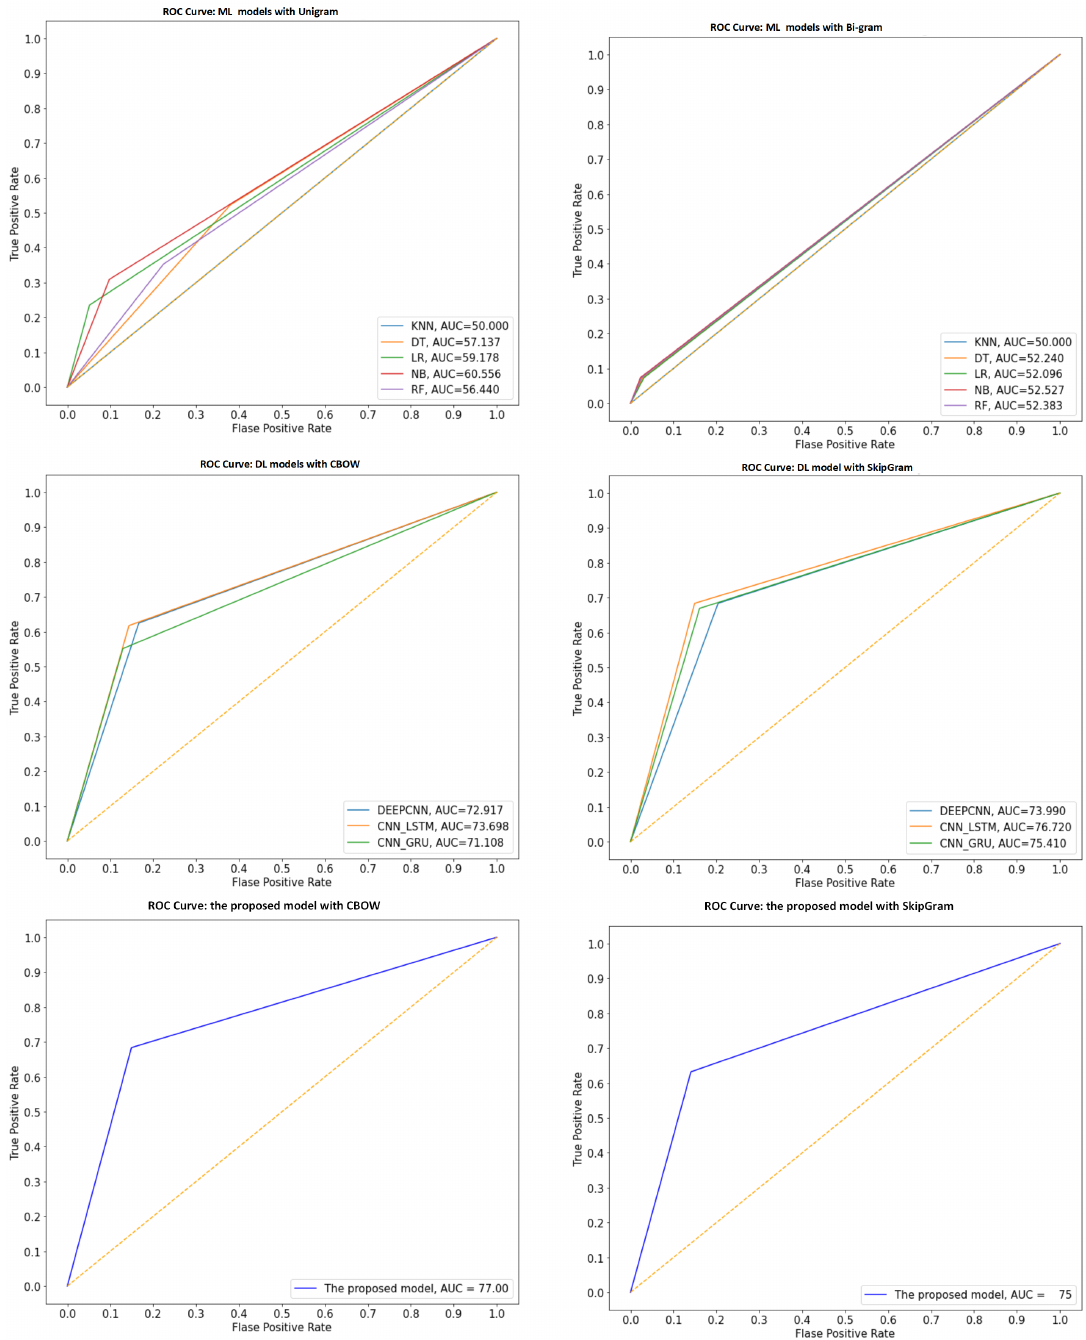
Figure 7. The AUC score for the ASTD